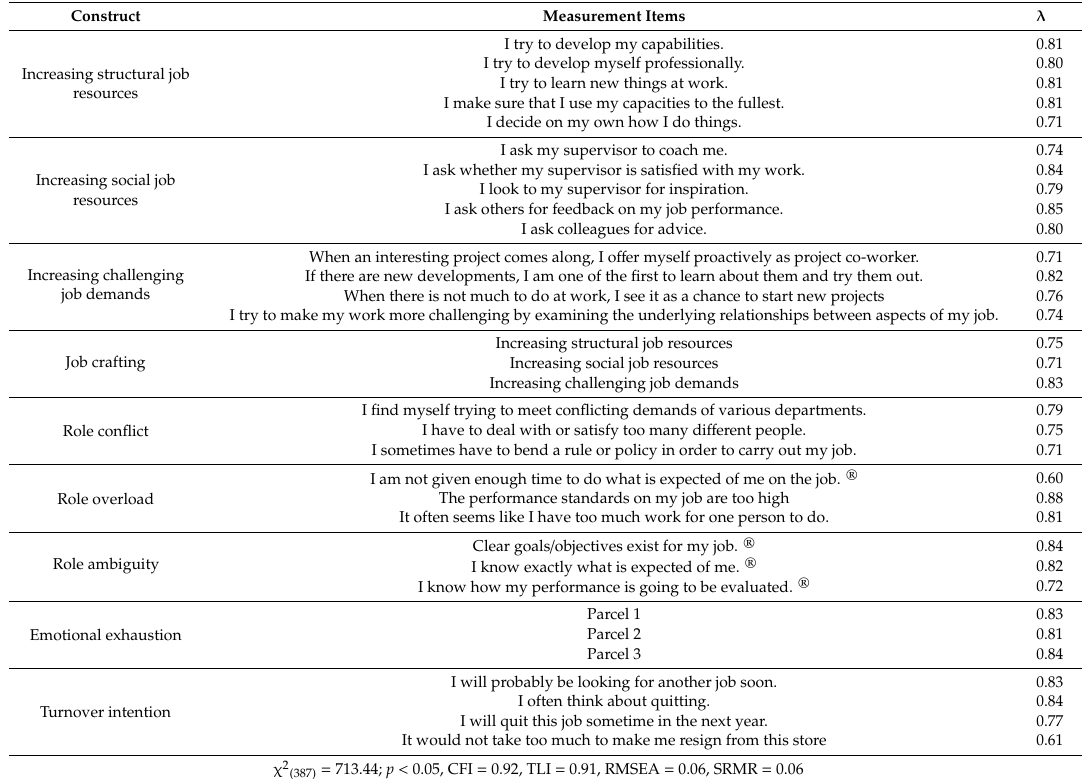
Table 1. CFA Results of Measurement